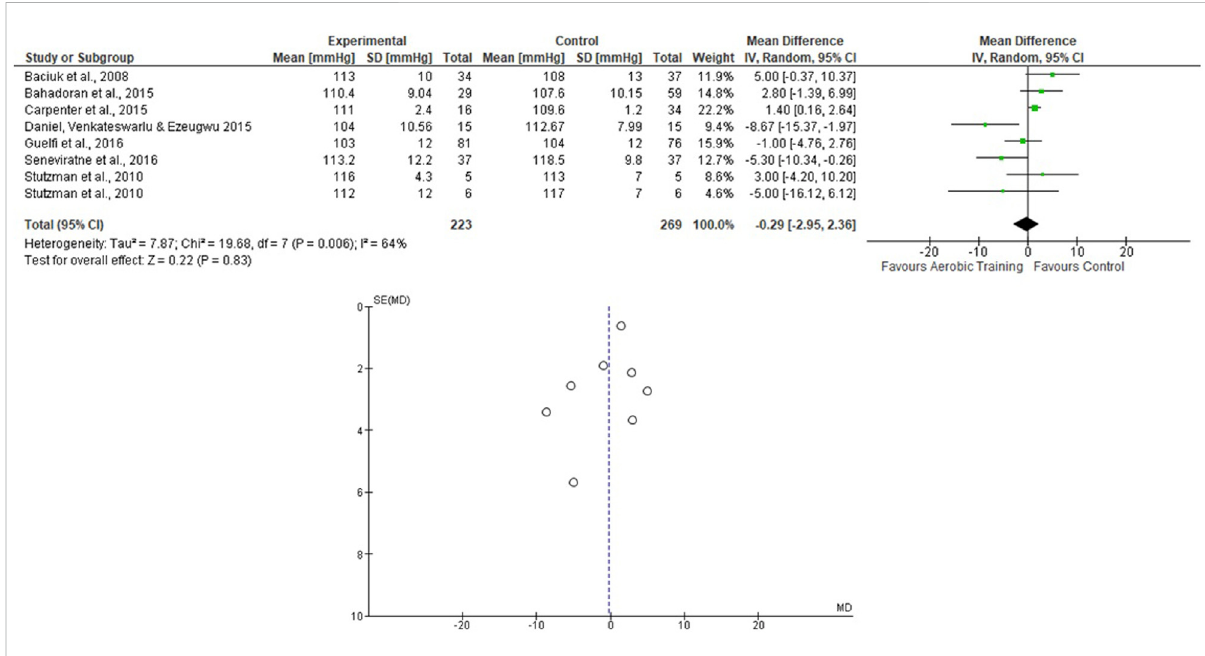
FIGURE 2 Effects of the AT on SBP in pregnant women and funnel plot for detecting bias and systematic